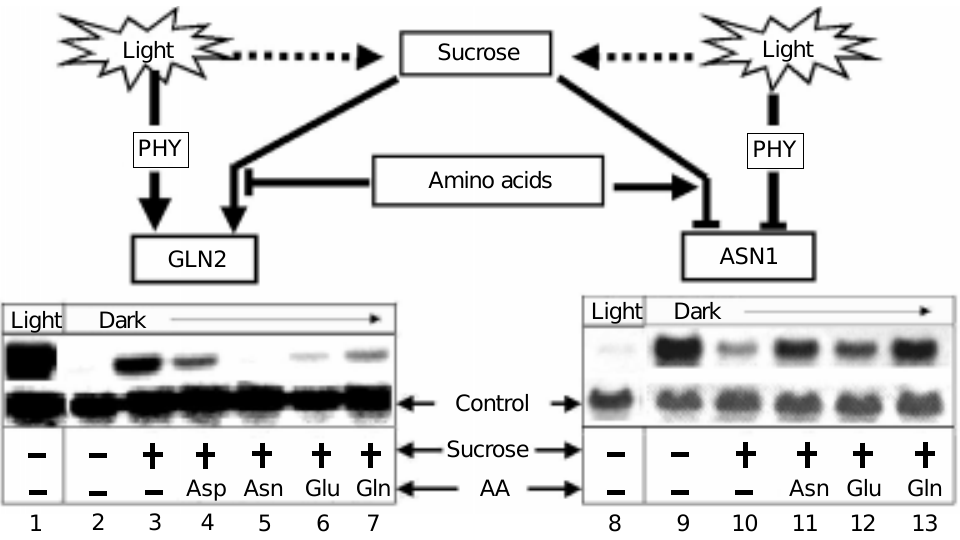
tially overlapping